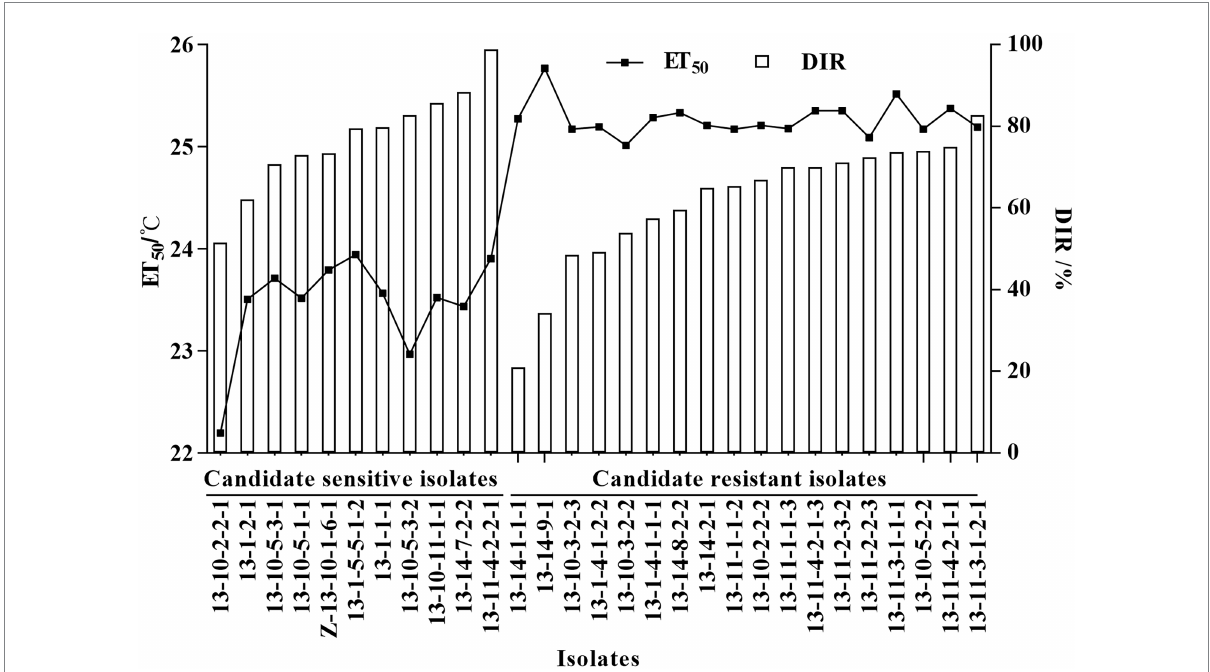
FIGURE 1 ET 50 and disease inhibition rate (DIR) at 26 ° C of 11 high-temperature-sensitive and 18 high-temperature-resistant candidate isolates of Blumeria gramini s f. sp. tritici . Line chart depicted the ET 50 , and bar chart depicted the DIR at 26 ° C.